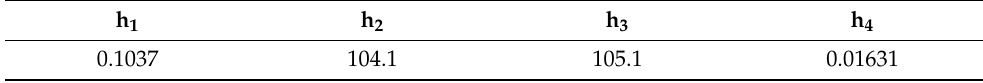
Table 3. Values of coefficients hi for the calculation of conversion factor k d for d = 3 mm [65]. h